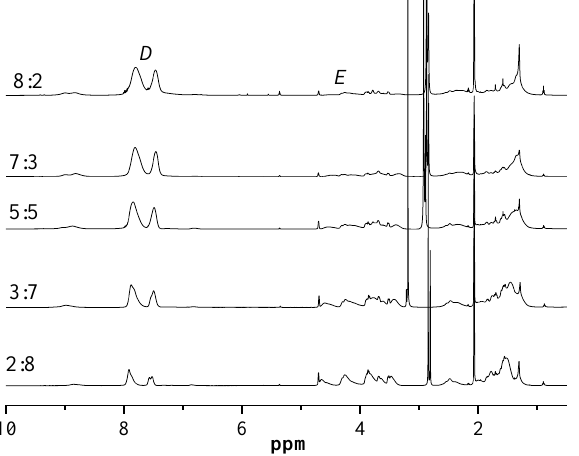
Figure 3. 1 H-NMR spectra of PMAAAB- ran -P(THP-HEA) copolymers.